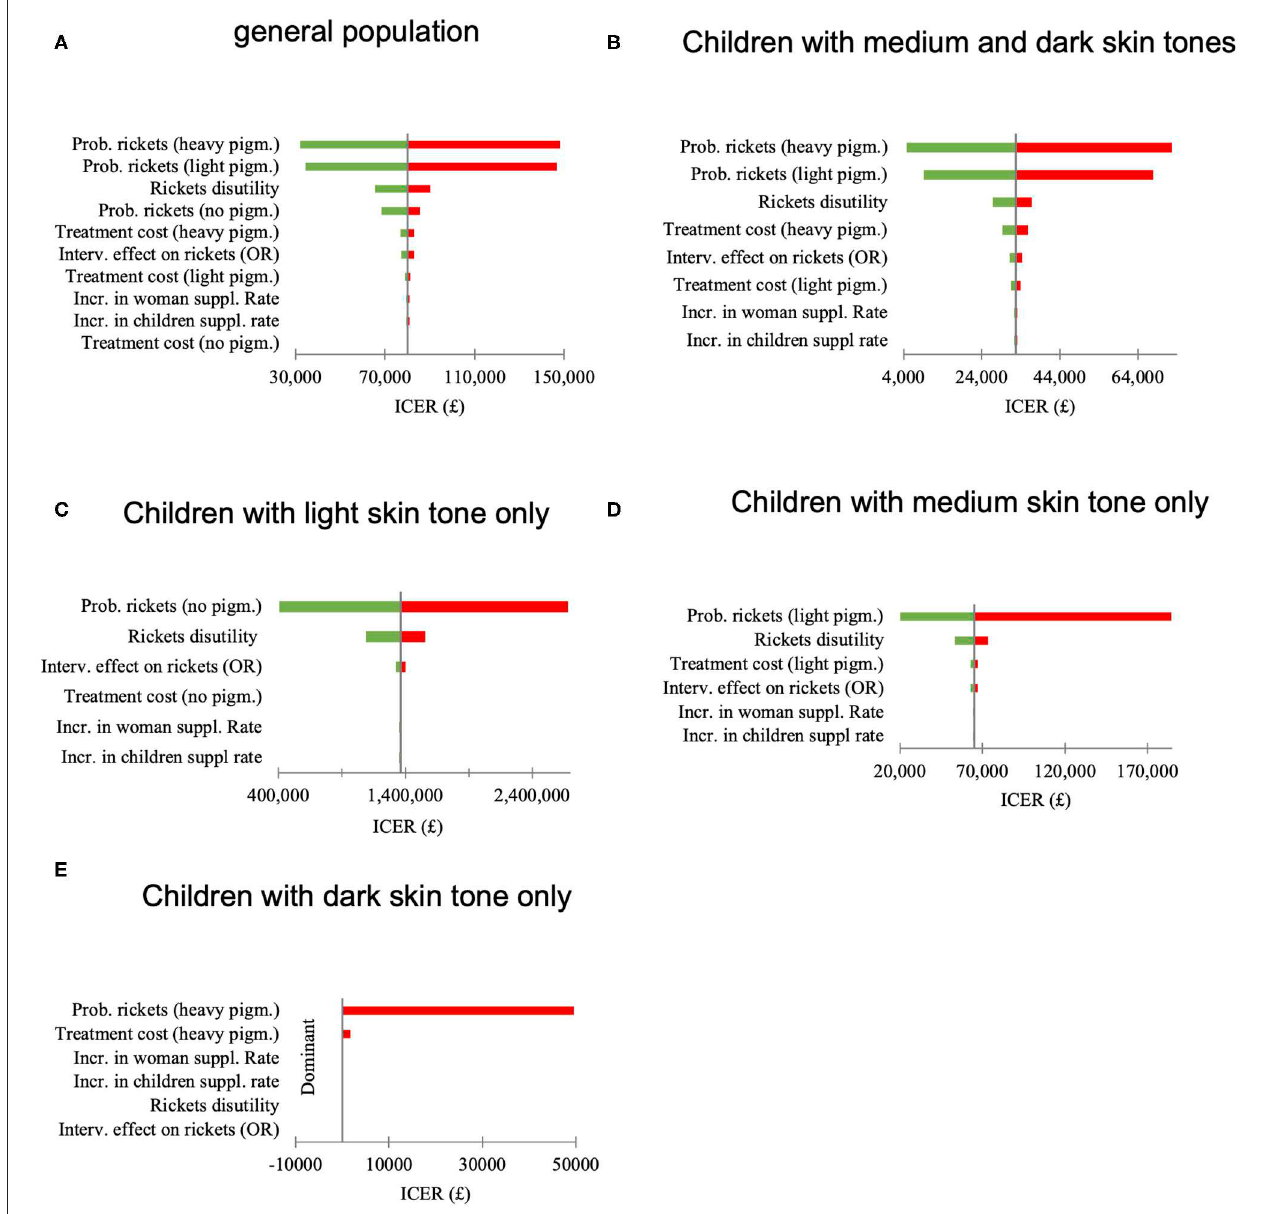
FIGURE 3 | (A–E) Univariate sensitivity analysis, effect of the parameter variation between 2 · 5th and 97 · 5th quintile on the incremental cost-effectiveness ratio (ICER)